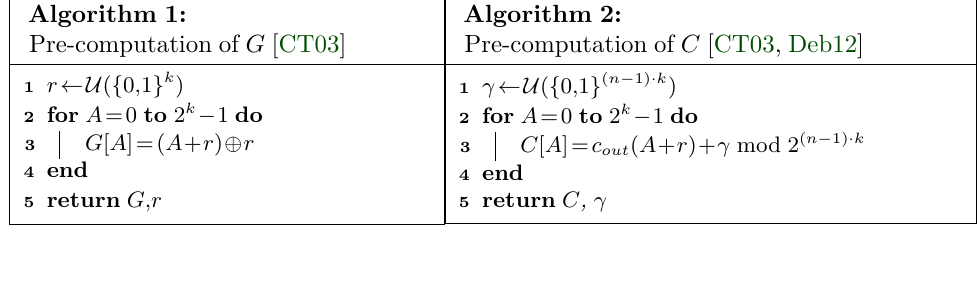
Algorithm 3: Table T generation